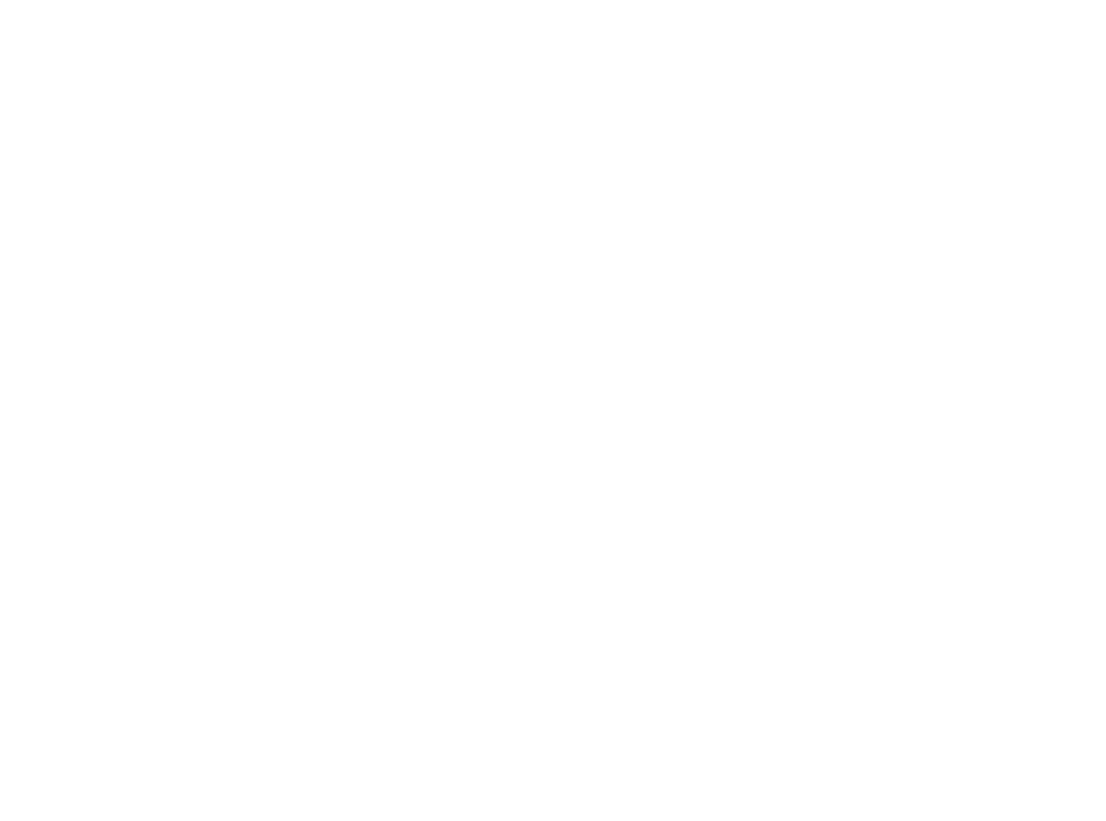
Fig 3. Histochemical analyses of GUS activity in ProGhWRKY68::GUS transgenic Arabidopsis . (A) ProGhWRKY68::GUS activity during different developmental stages. (B) Activity of the ProGhWRKY68::GUS construct in different tissue regions. (C) Histochemical assays of GUS activity in response to various stresses.